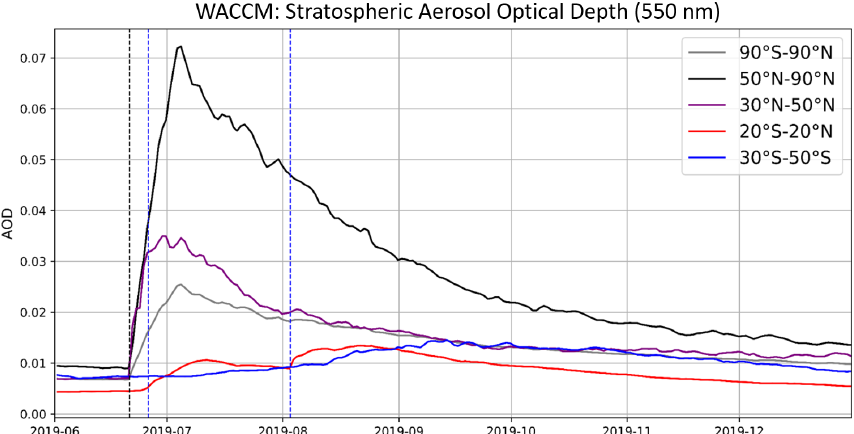
Figure C1. Respective to Fig. 8a and b, WACCM means sAOD values. The WACCM sAOD is shown here for sulfate only, i.e., with no condensation of water, to eliminate the signature of PSCs in the winter hemisphere, which would likely mask the signature of the plume closer to the